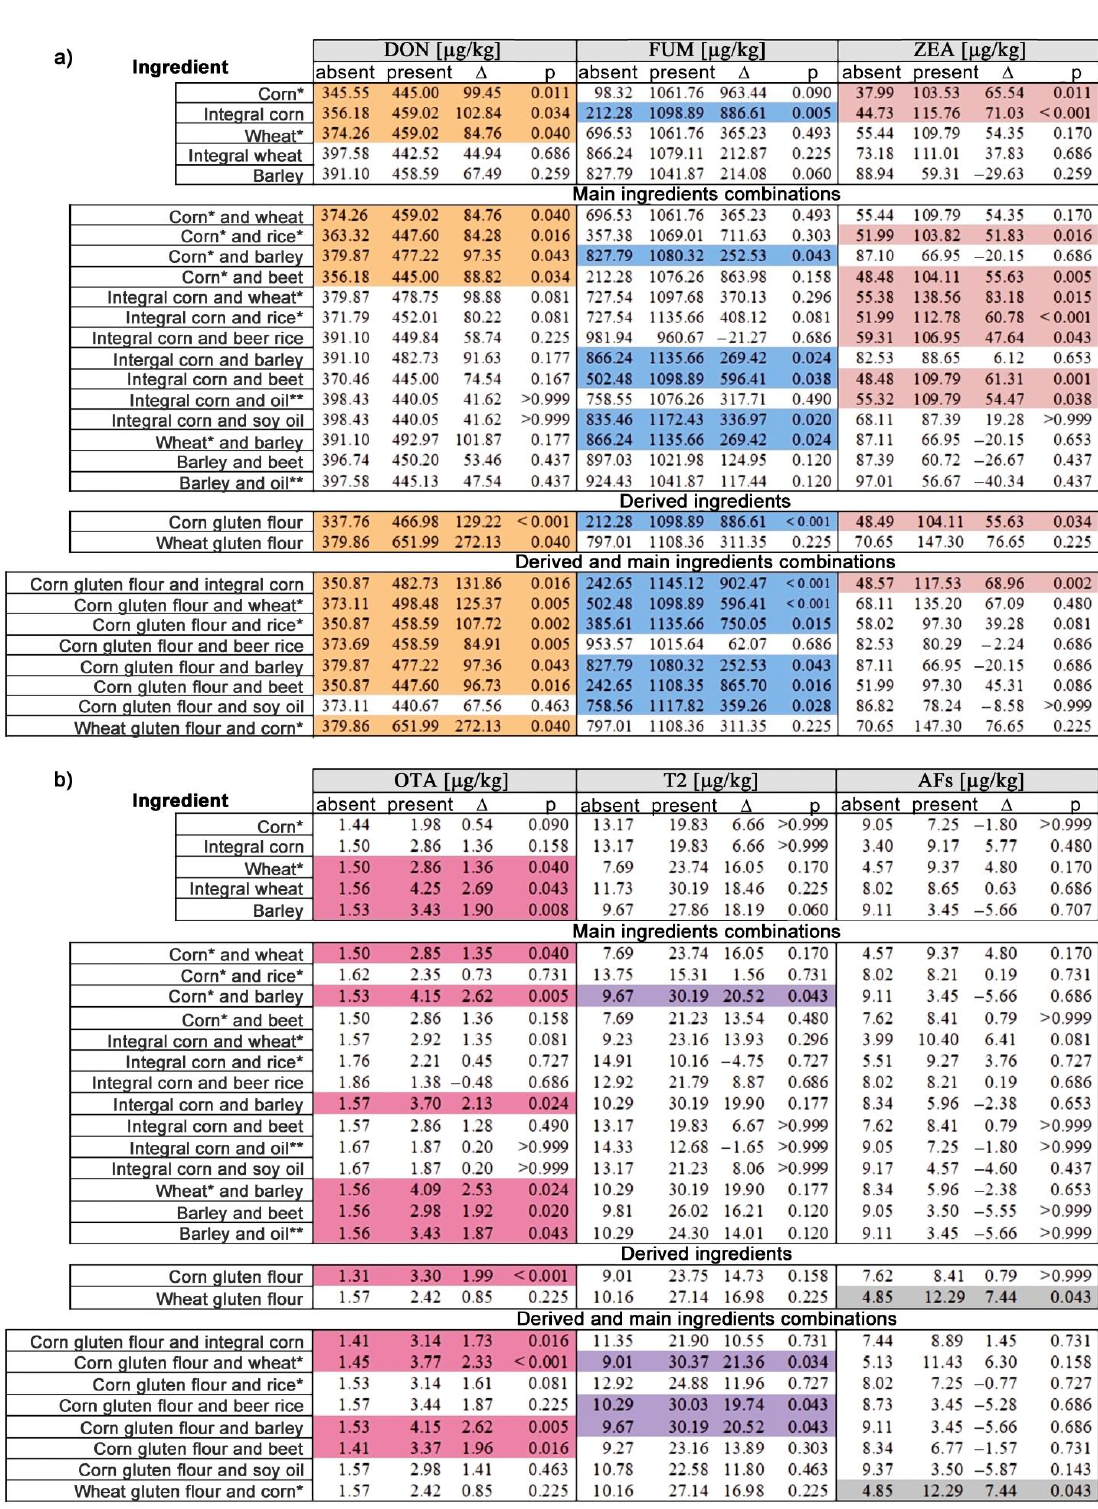
Figure 2. Positive and statistically significant differences in the median levels of ( a ) DON, FUM, and ZEA and ( b ) OTA, T2, and AFs mycotoxins in groups defined (absence or presence) of some main ingredients, some derived ingredients, or their combinations in the composition of the samples. The statistically significant differences for DON are highlighted in orange, for FUM in blue, for ZEA in pale pink, for OTA in pink, for T2 toxin in purple, and AFs in gray. * All derived ingredients included; ** All origins